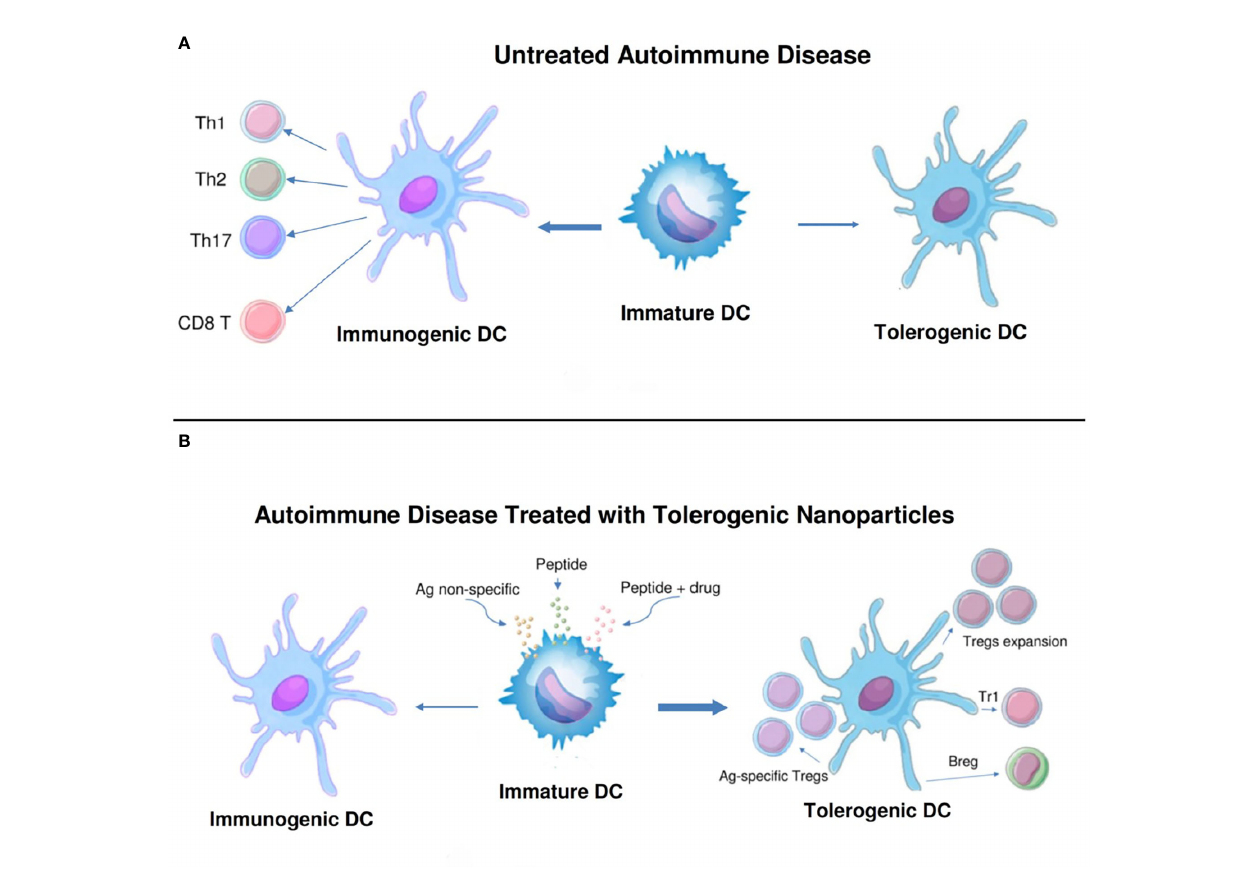
FIGURE 2 | Nanoparticles targeted to antigen-presenting cells can switch immunogenic dendritic cells to tolerogenic. (A) . While immature dendritic cells (DCs) normally mature to tolerogenic in the steady state, in untreated autoimmune disease these cells can become immunogenic and induce pathogenic T cell effector cells (CD4 + Th1, Th2 and Th17, and CD8 + T cells). (B) . Different formulations of nanoparticles (antigen non-speci fi c, peptide-containing, or peptide plus drug) have been designed to switch the maturation of DCs from immunogenic back to tolerogenic. These DCs expand one or more populations of regulatory cells (antigen- speci fi c and non-speci fi c CD4 + and CD8 + Tregs, Tr1 cells, and B regulatory cells) and reset the immune system to restore a predominance of regulatory cells over pathogenic effector